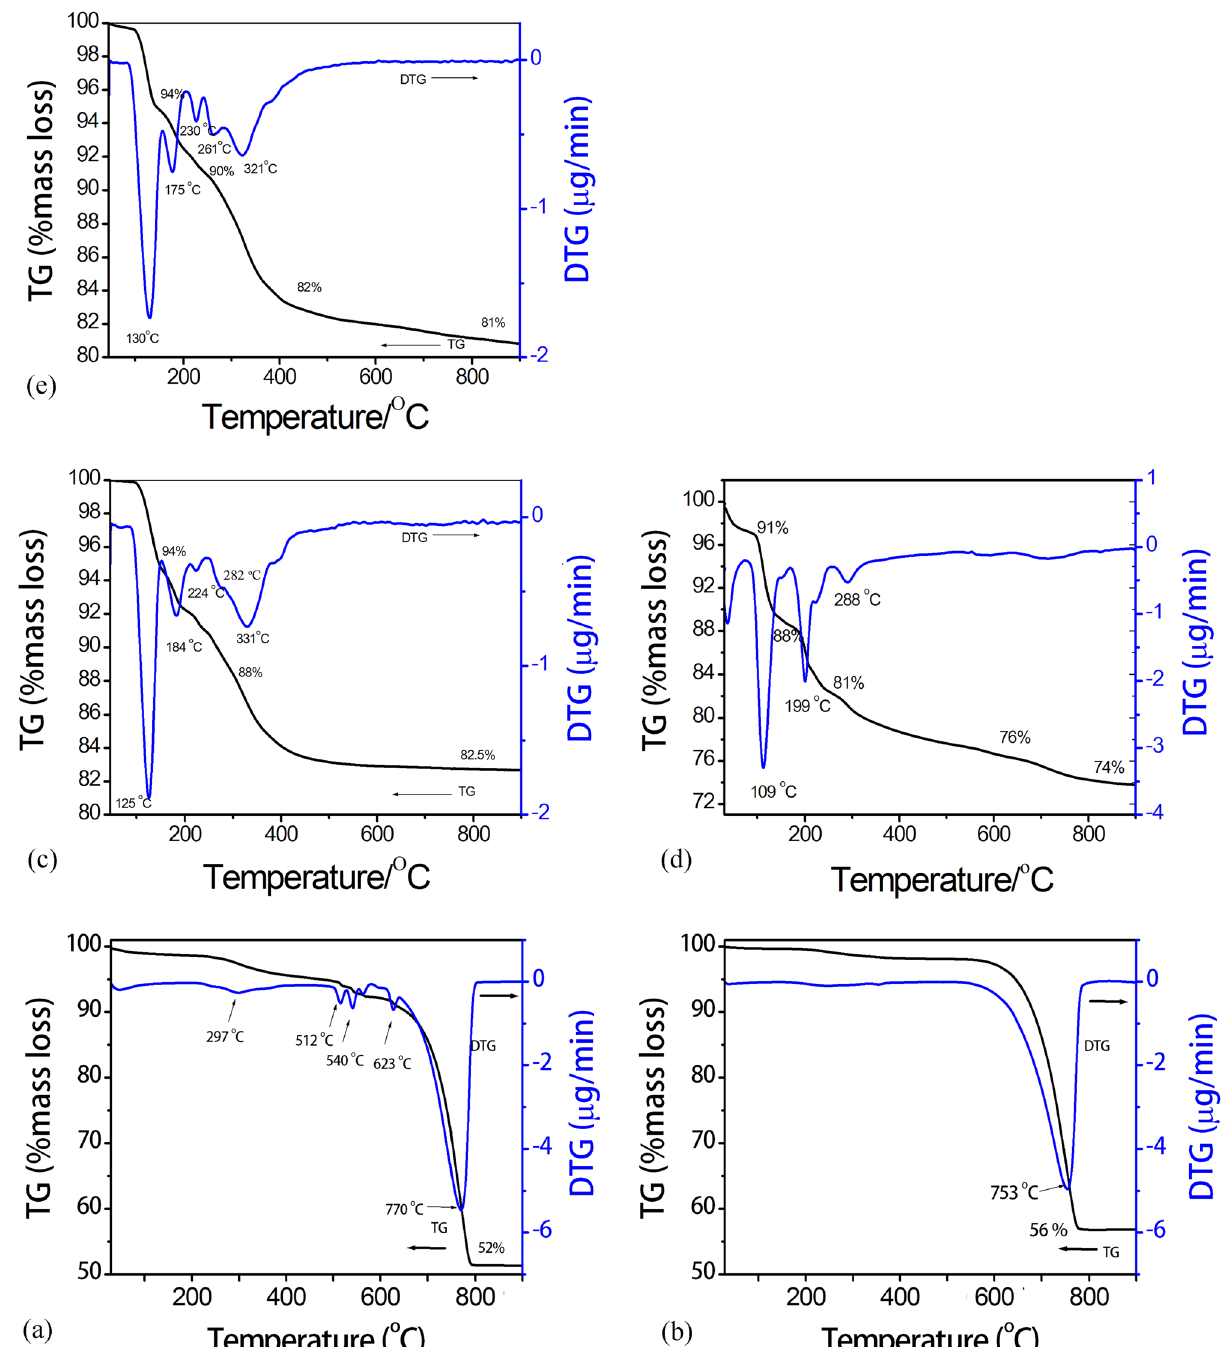
Figure 6. TG/DTG curves of LPC ( a ), HPC ( b ), triple superphosphate ( c ), dicalcium phosphate dihydrate ( d ), and monocalcium phosphate monohydrate ( f